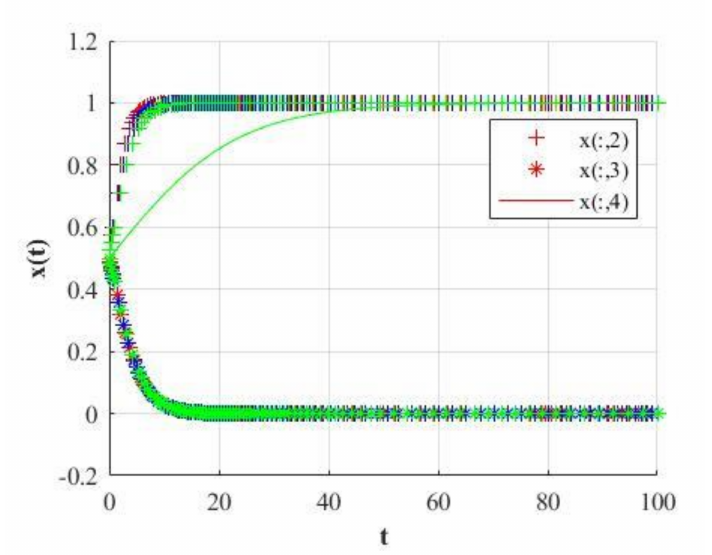
Figure 17. Change the parameter δ 2 = 0.2 (red curve), 0.6 ((blue curve), 0.9 (green curve) to take the value of the three-way strategy evolution diagram.